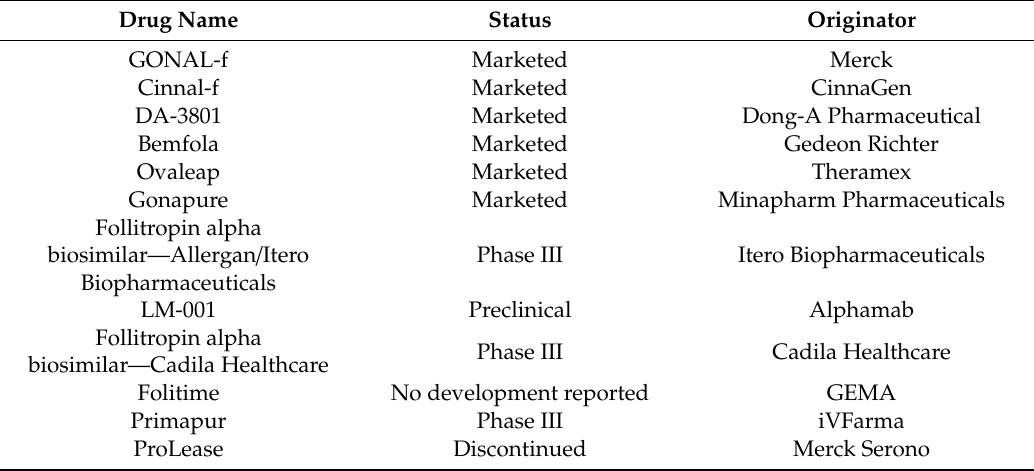
Table 1. FSH originator and